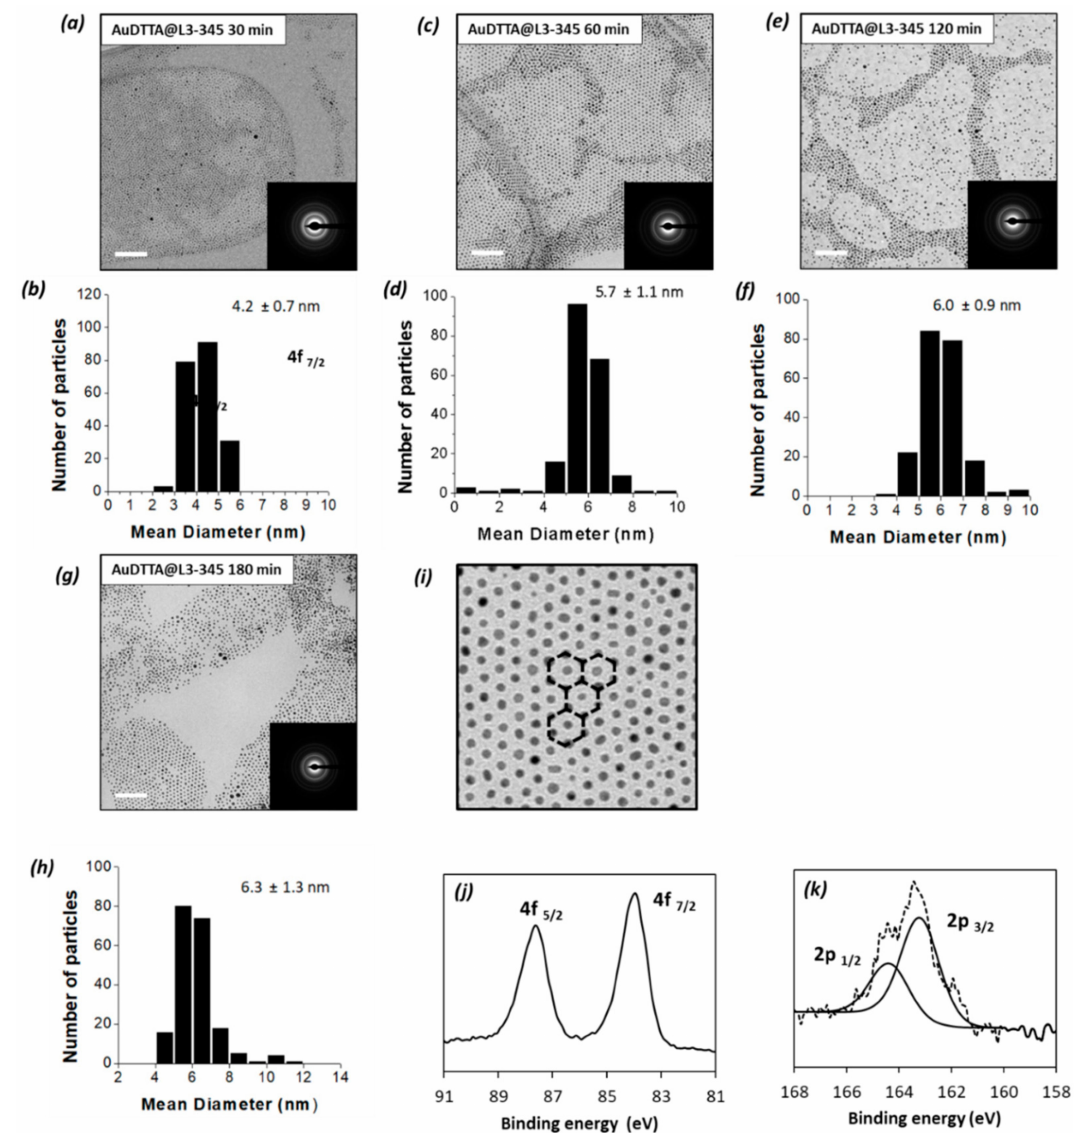
Figure 5. TEM microphotographs with their SAED patterns ( a , c , e , g ) and nanoparticle size distribution histograms ( b , d , f , h ) of AuDT-AT-TA@L3-3,4,5 after 30, 60, 120 and 180 min of isothermal treatment at 150 ◦ C. ( i ) Magnification of the image of AuDT-AT-TA@L3-3,4,5 (60 min) where it is possible to observe short-range interaction between nanoparticles with local hexagonal order. ( j ) HRXPS spectra of Au 4f and ( k ) S 2p orbitals in AuDT-AT-TA@L3-3,4,5